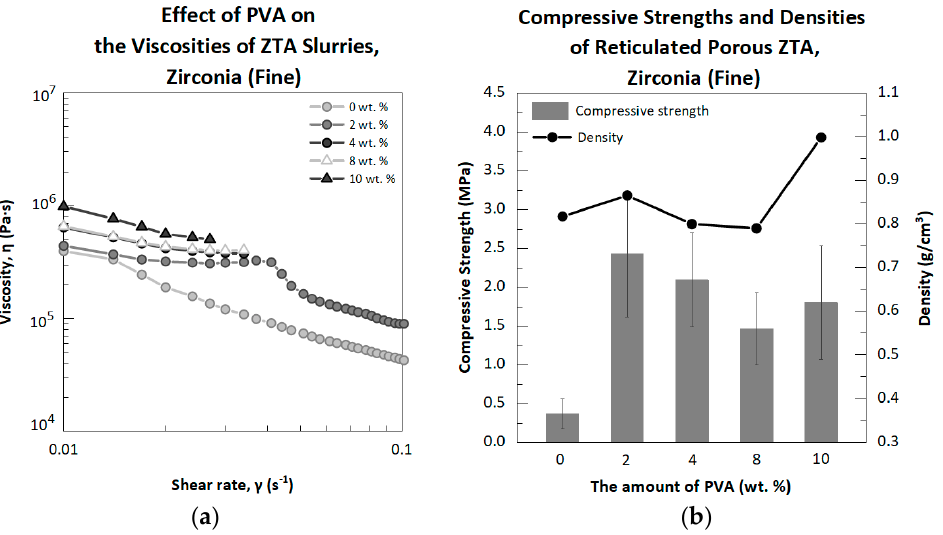
Figure 8. ( a ) Viscosities of the ZTA slurries with the amount of PVA ( b ) compressive strengths and densities with the amount of PVA.